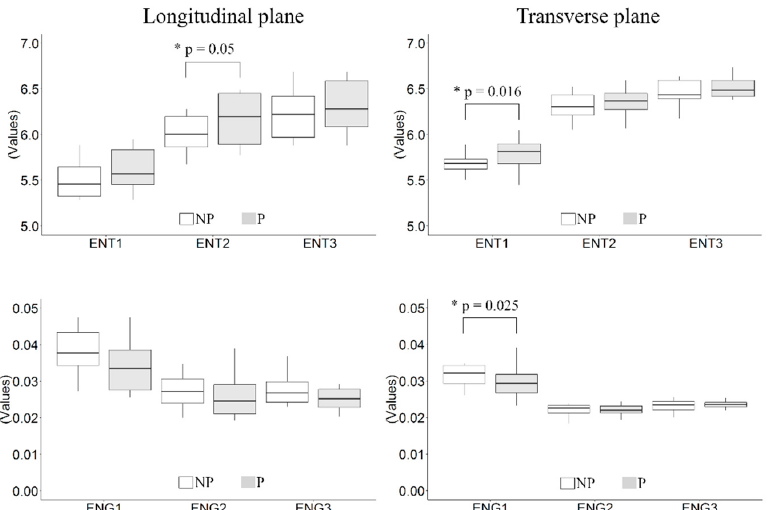
Figure 4. The local binary pattern (LBP) features with multiscale analysis. The entropy (ENT) and energy (ENG) of the LBP were extracted by the different radius (R = 1, 2, 3) and compared between paretic (P) and non-paretic (NP) biceps brachii muscle in the longitudinal and transverse planes.